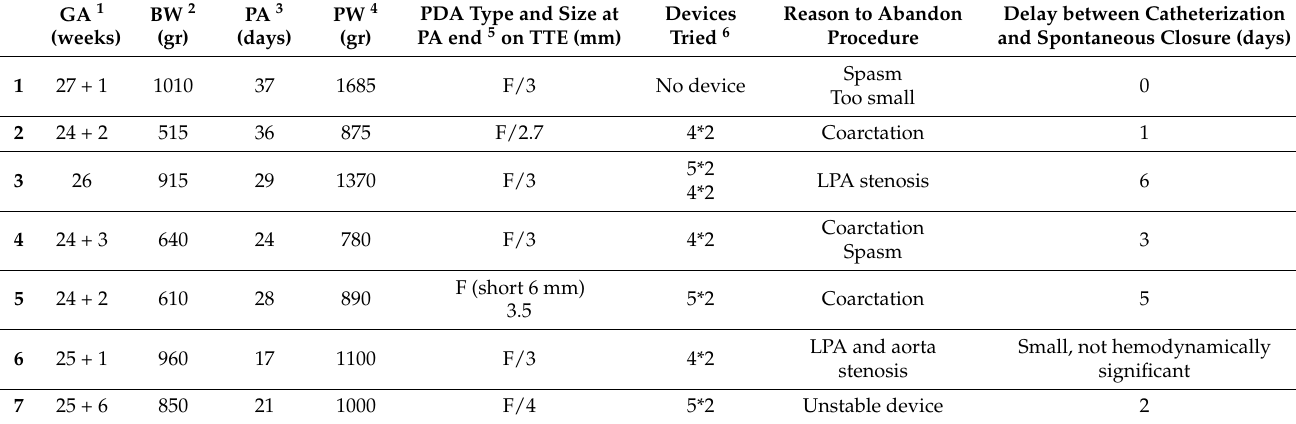
Table 1. Characteristics of the seven patients with patent ductus arteriosus (PDA) permanent spontaneous closure after attempted percutaneous